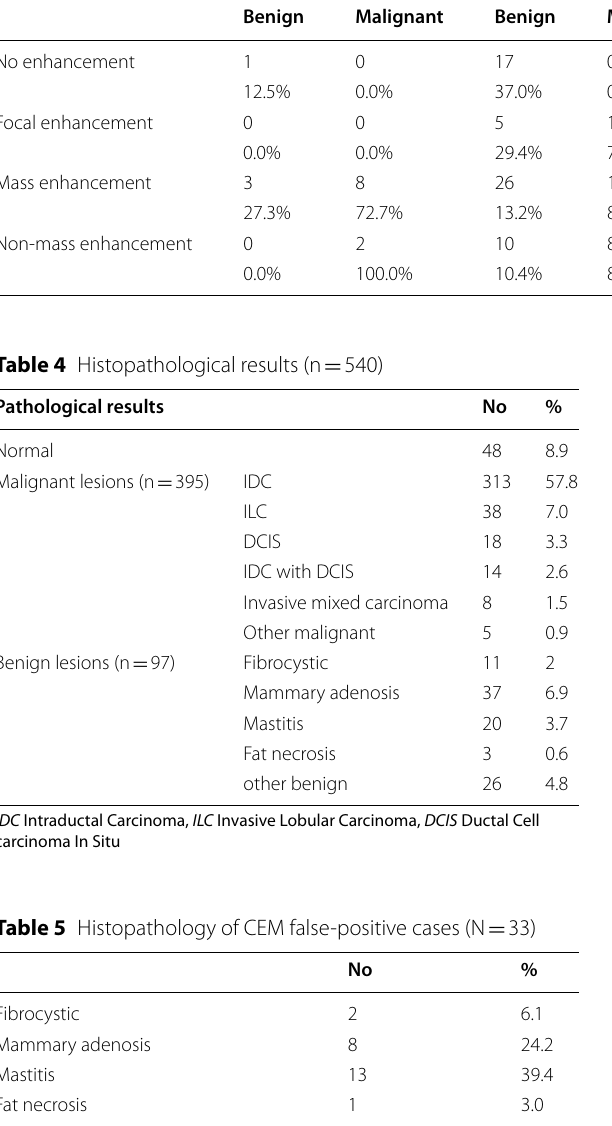
overlapping tissues, 88/380 (23.2%) were benign lesions, and 257/380 (67.6%) were malignant lesions.